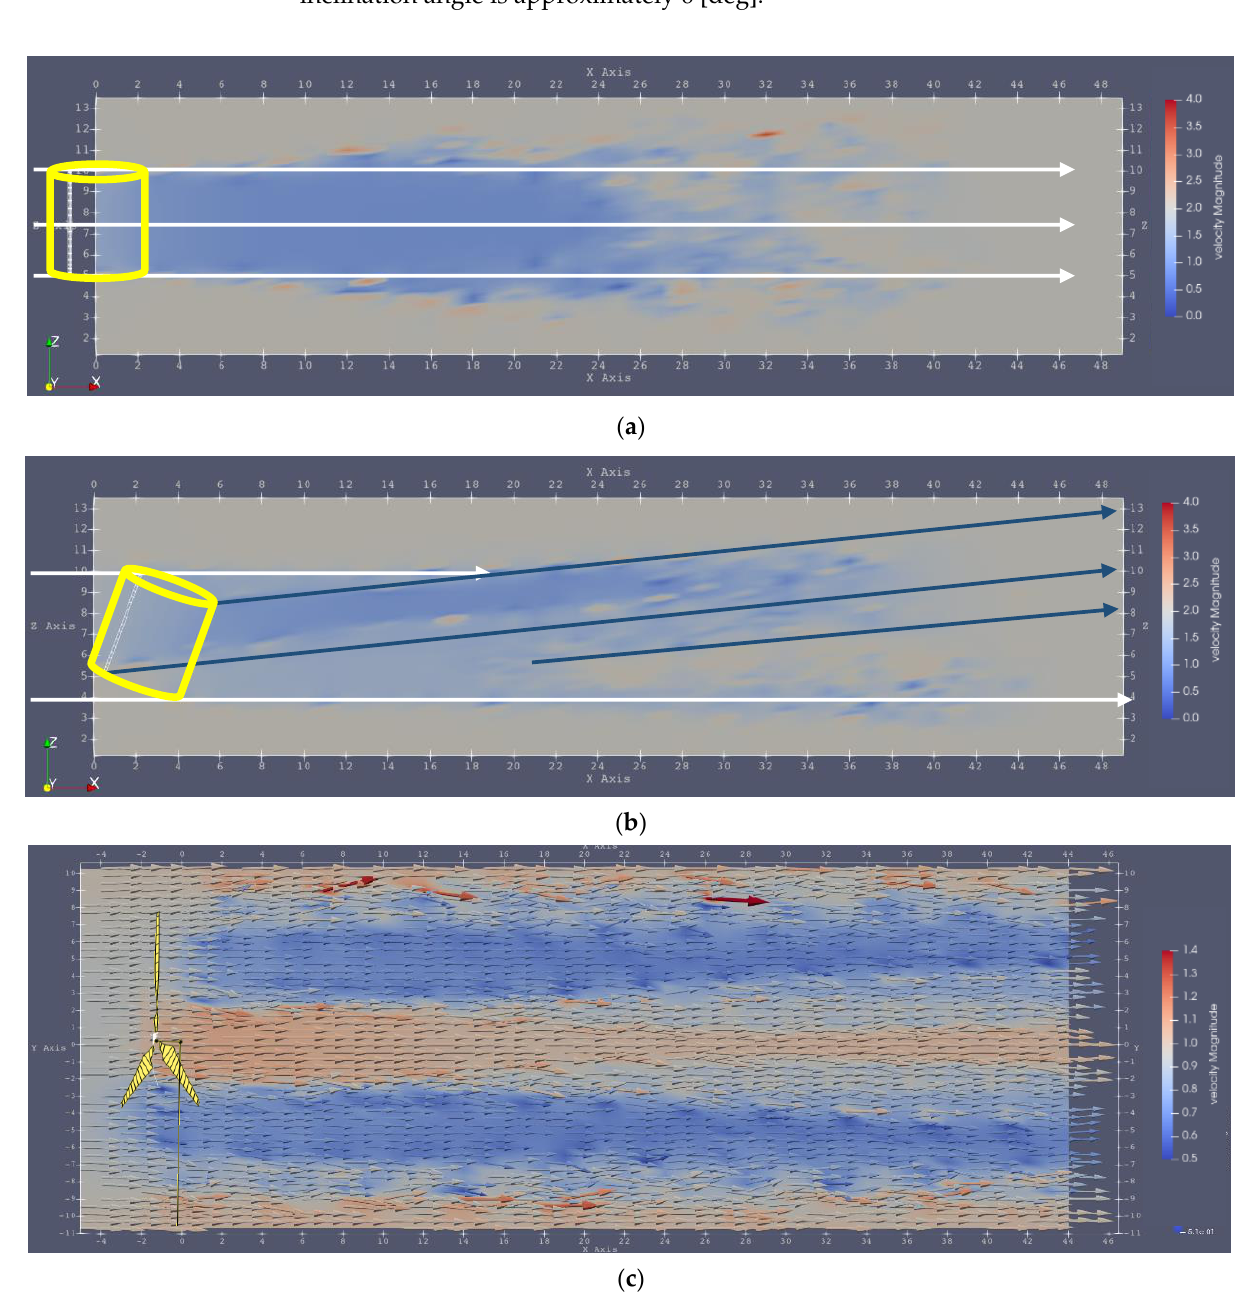
Figure 7. Magnitude of in-plane wind velocity: ( a ) upright VAWT; ( b ) 20-degree-tilted VAWT; ( c ) upright HAWT.